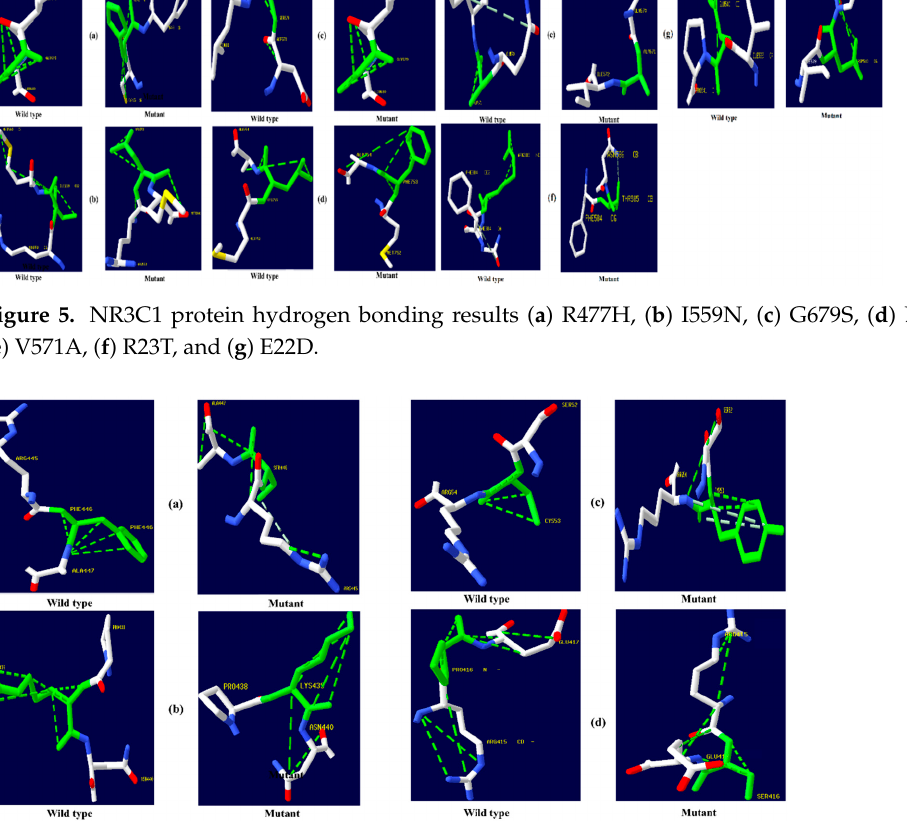
Figure 6. CYP3A5 protein hydrogen bonding results ( a ) F446S, ( b ) R439K, ( c ) Y53C, and ( d ) P416S. Table 5. Prediction of relative surface accessibility of TNF- α through NetsurfP.